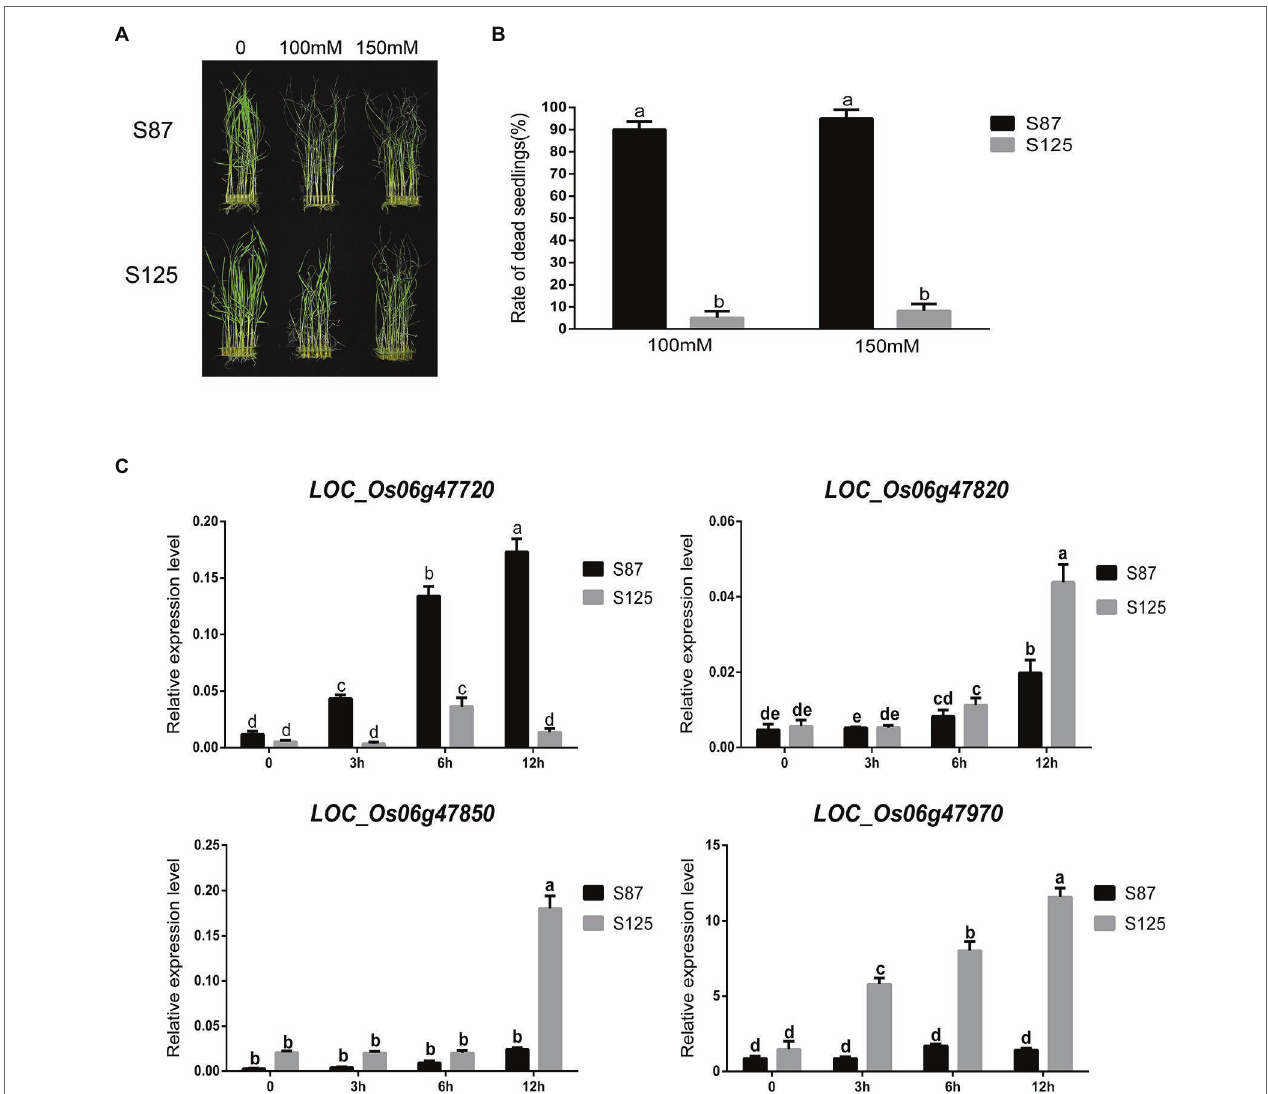
FIGURE 5 | (A) Phenotypes of S87 (salt sensitive variety) and S125 (salt tolerant variety) at different salt concentrations. (B) Statistical analysis of S87 and S125 for dead seedling rate, where the a and b are ranked by Duncan’s test at p < 0.05. (C) changes in relative gene expression level of four candidate genes at different times (0, 3 h, 6 h, 12 h) after salinity stress in different rice cultivars, where the a, b, c, d, and e are ranked by Duncan’s test at p <